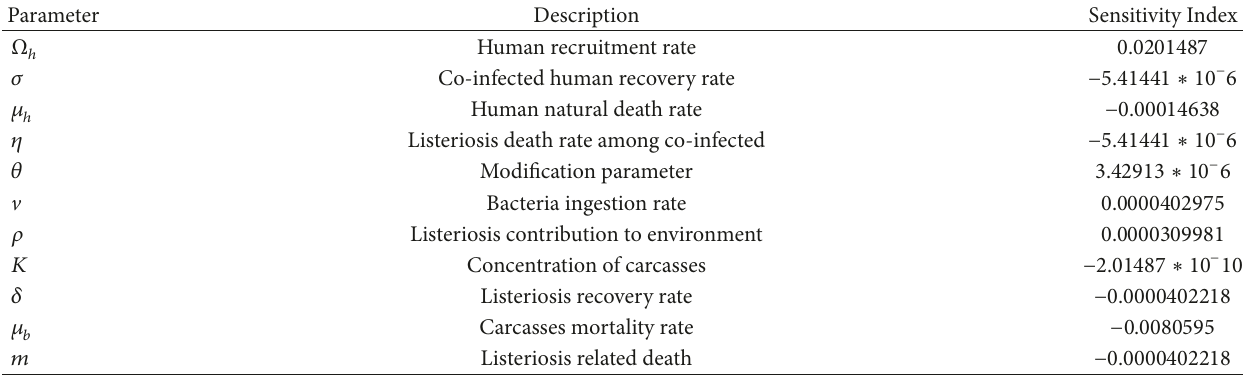
Table 2: Sensitivity indices of R 0𝑙 to each of the parameter values.